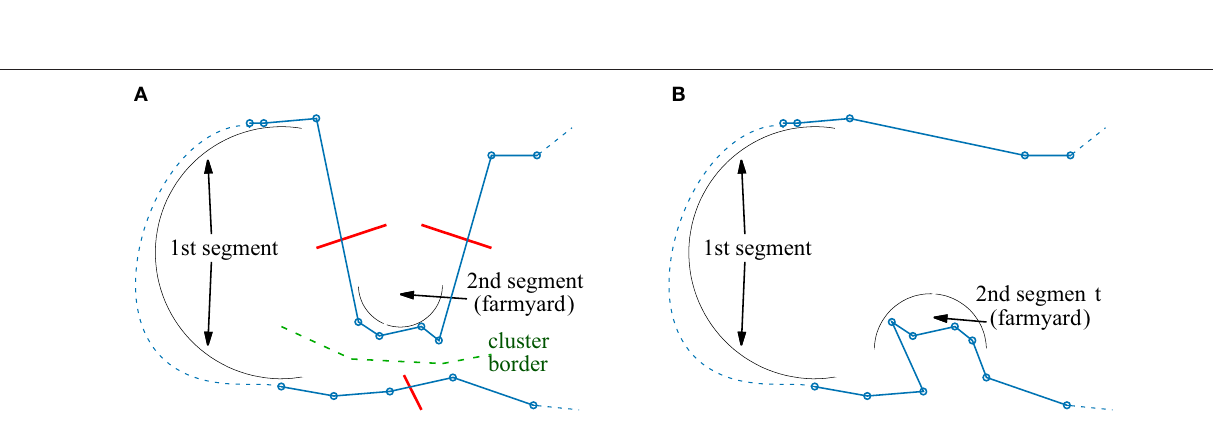
Frontiers in Robotics and AI |